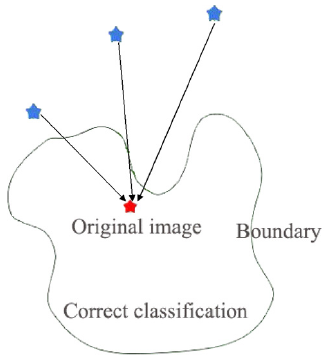
Figure 3. General view about the initial point of selection.